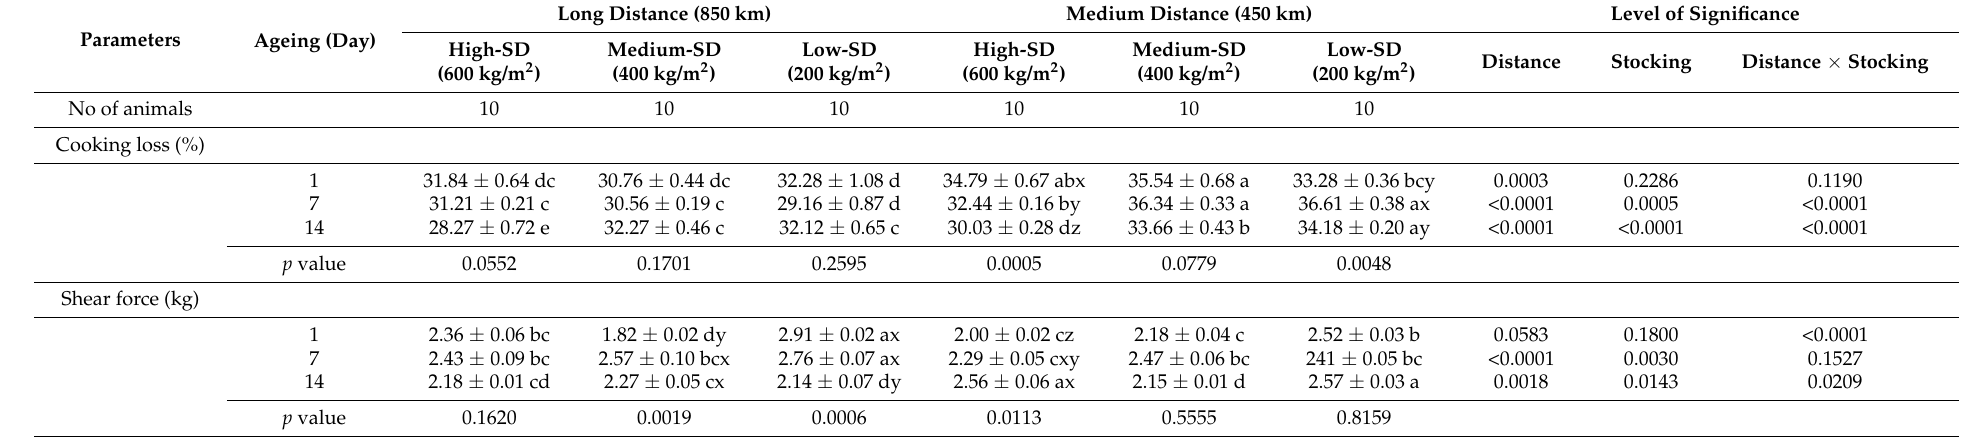
Table 3. Differences in cooking loss and shear force values of Longissimus lumborum muscle during postmortem ageing periods in cattle subjected to different distances and stocking densities (SD) during road transport.